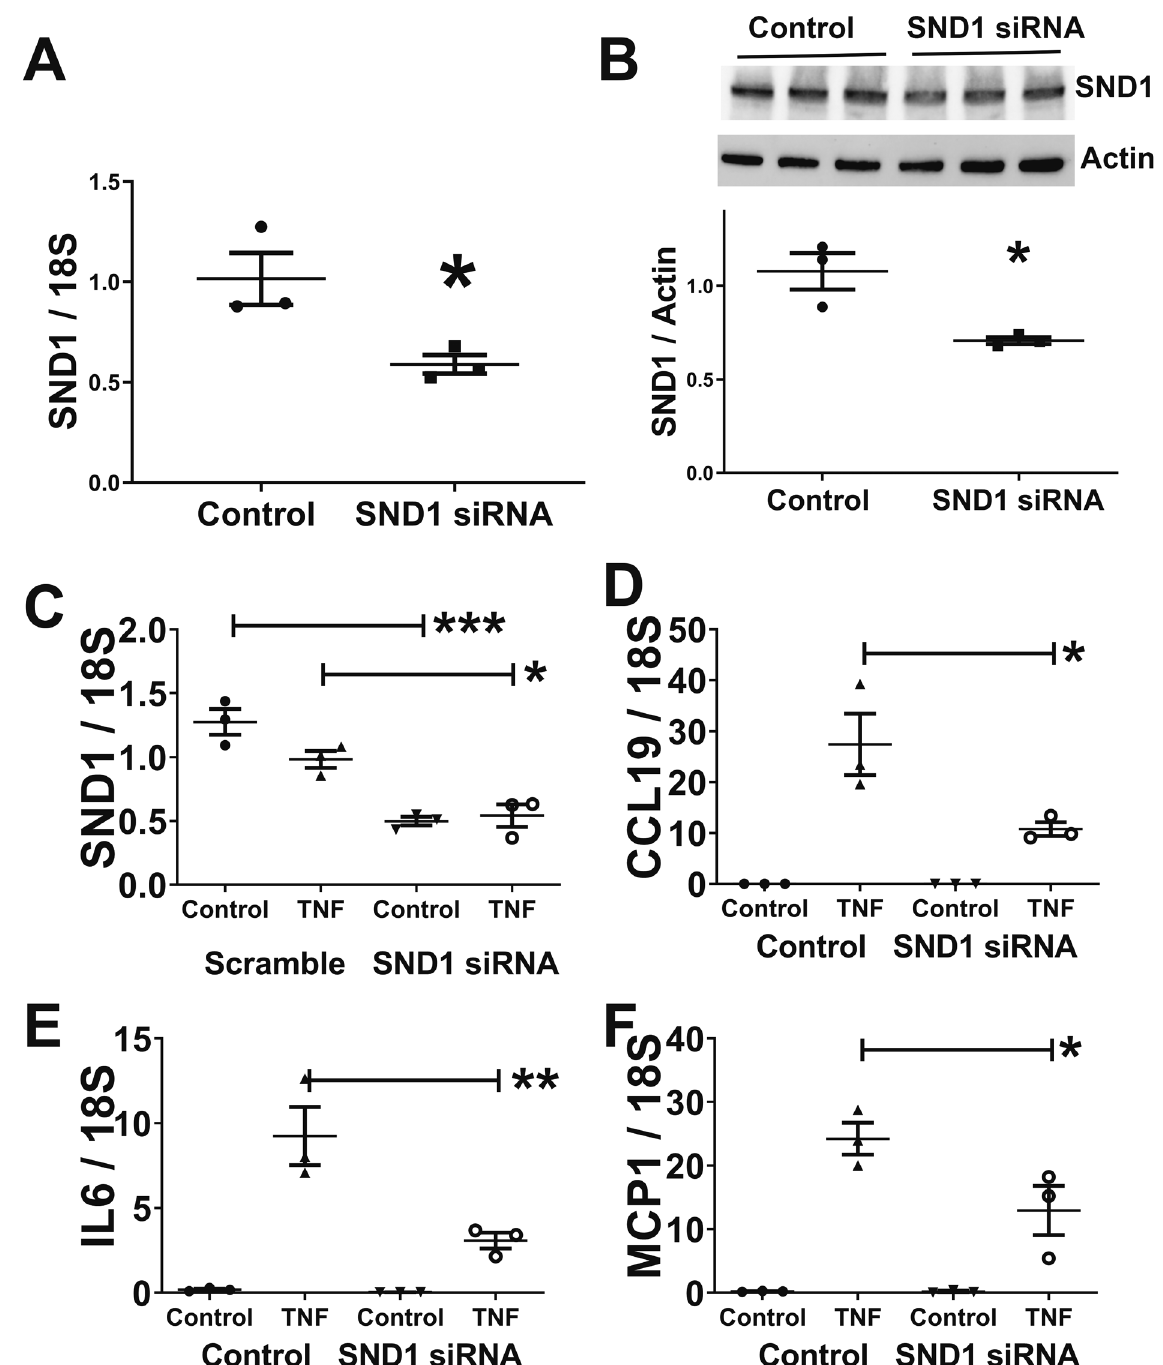
Figure 6. SND1 promotes inflammatory gene expression in adipocytes. ( A , B ) Differentiated 3T3-L1 adipocytes were treated with control (scrambled) or Snd1 siRNA as indicated, and Snd1 1 mRNA expression and protein expression were determined. ( C – F ) Differentiated 3T3-L1 adipocytes were treated with control or Snd1 siRNA as indicated. Next, they were treated with 20 ng/mL TNFα for 6-h. The mRNA expression of ( C ) SND1, ( D ) CCL19, ( E ) IL6, and ( F ) MCP1 was determined with real time RT-PCR. The data are represented as the mean ± SEM (n = 3; *P < 0.05; **P < 0.01; ***P < 0.01; one way ANOVA with Tukey post hoc test); the data for SND1 is log